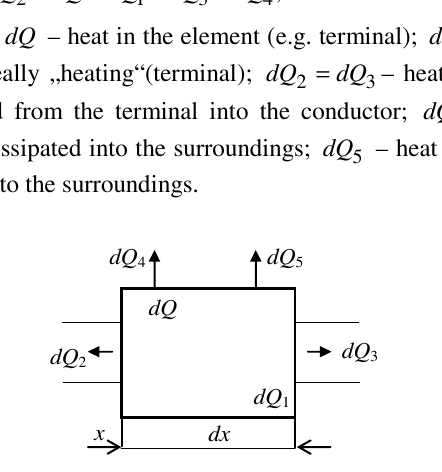
Fig 1. Thermal balance illustrated schematically